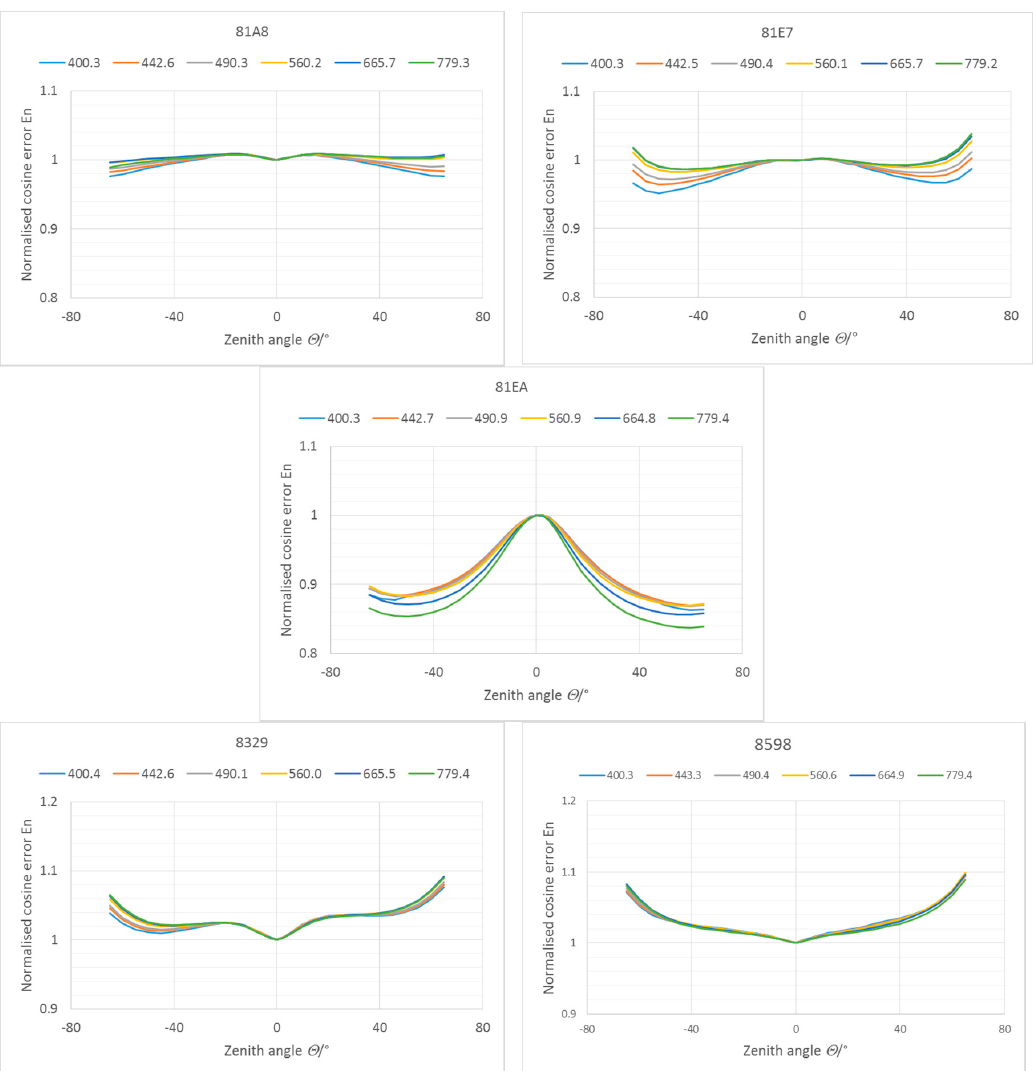
Figure 13. Normalized cosine response error of five RAMSES sensors. Remote Sens. 2018 , 10 , x FOR PEER REVIEW